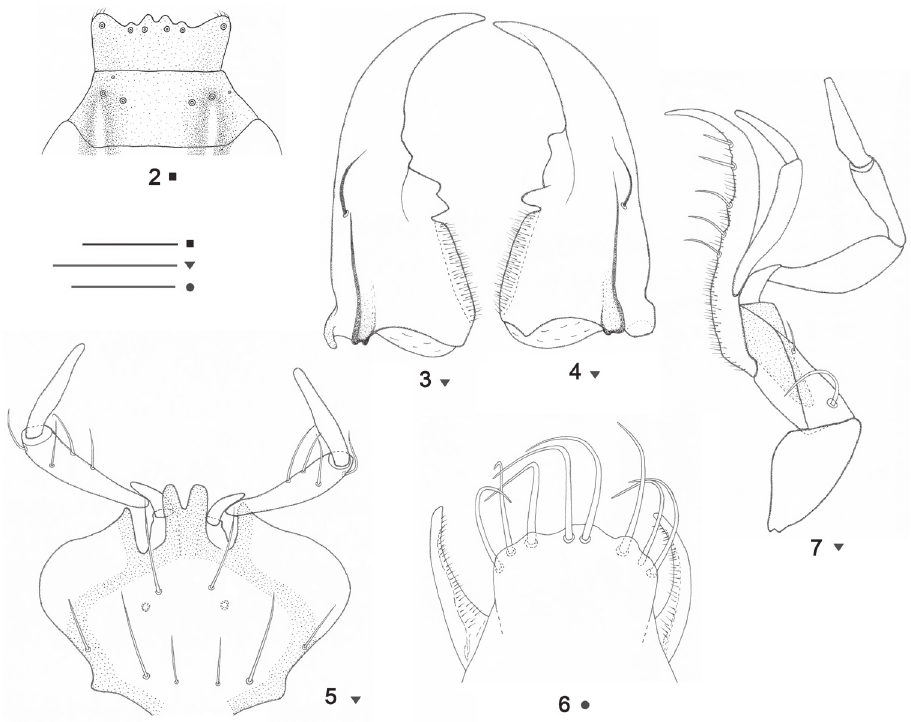
Figures 2–7. Beronaphaenops gen. n. paphlagonicus sp. n. 2 Labrum and clypeus in dorsal aspect, holo- type. 3 Left mandible in dorsal aspect, paratype ♀ 4 Right mandible in dorsal aspect, paratype ♀ 5 La- bium in ventral aspect, paratype ♀ 6 Apical part of ligula in ventral aspect, paratype ♀ 7 Left maxilla in ventral aspect, paratype ♀ . Scale bar 2, 3, 4, 5, 7 = 0.3 mm; 6 : 0.1